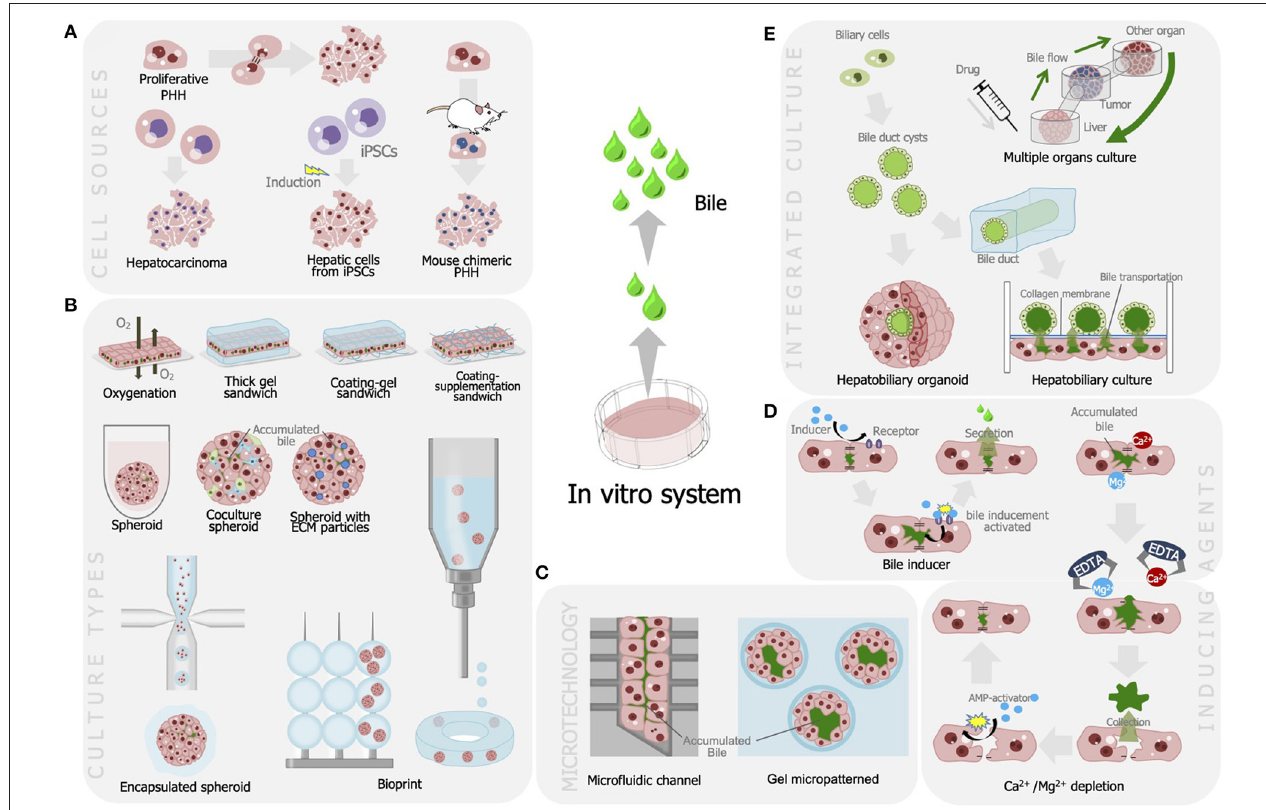
FIGURE 1 | Strategies developed for improving bile production and recovery for liver cell-based assay including (A) utilization of various cell sources for optimum bile production; (B) modulation of culture model that is efficient for bile secretion and production; (C) integration with microfabrication, modulation of bile production, and recovery methods using (D) agents and chelates; and (E) integration of liver tissues to enable autologous bile recovery.